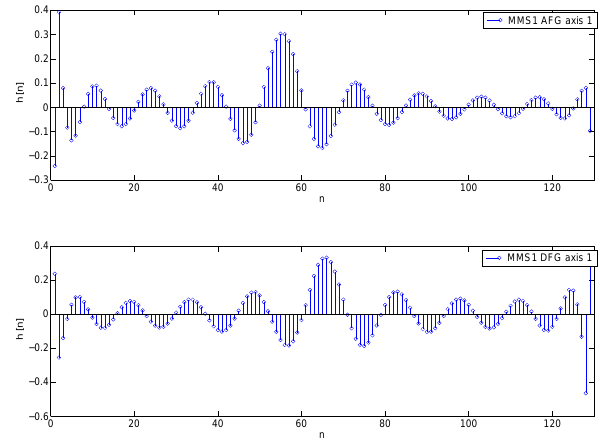
Figure 5. Exemplary impulse response of fluxgate compensation filter